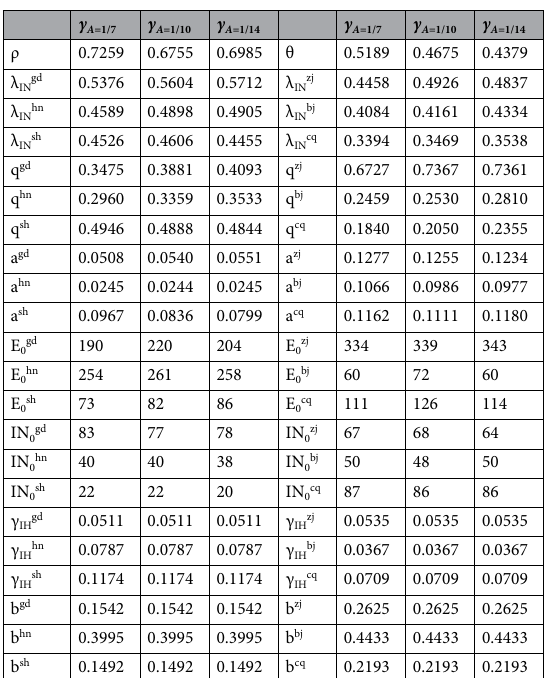
Table 1. Parameter